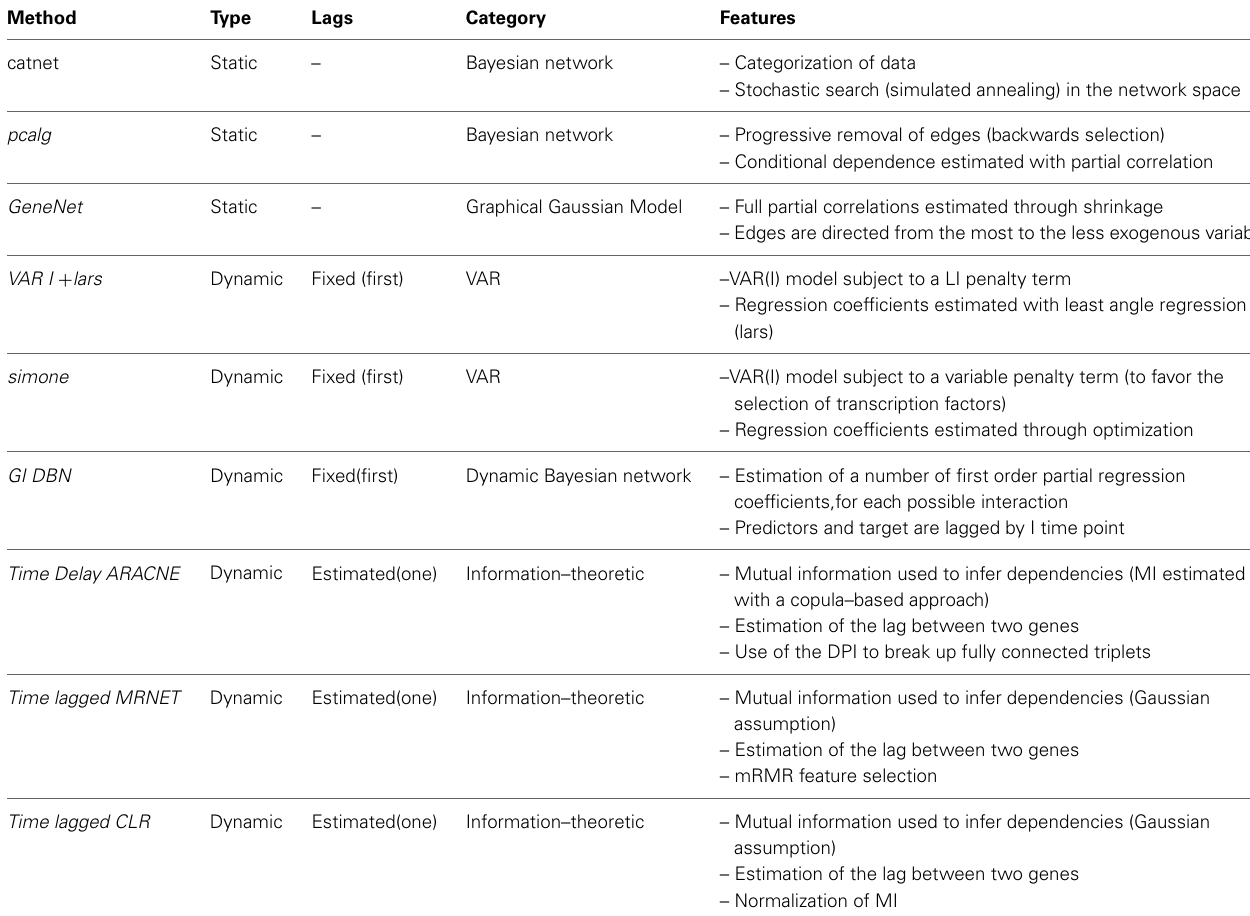
Table 1 | Assessed network inference